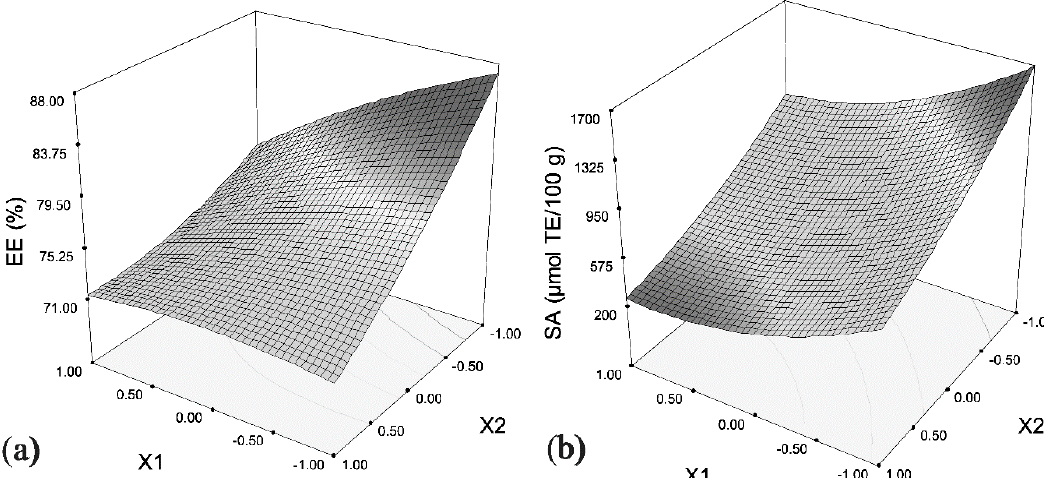
Figure 1. The influence of encapsulation parameters on ( a ) EE of beetroot pomace polyphenols and ( b ) SA of beetroot pomace extract encapsulates.